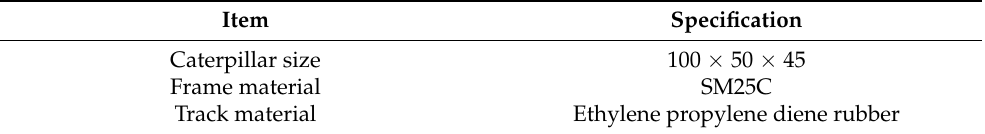
Table 1. Caterpillar